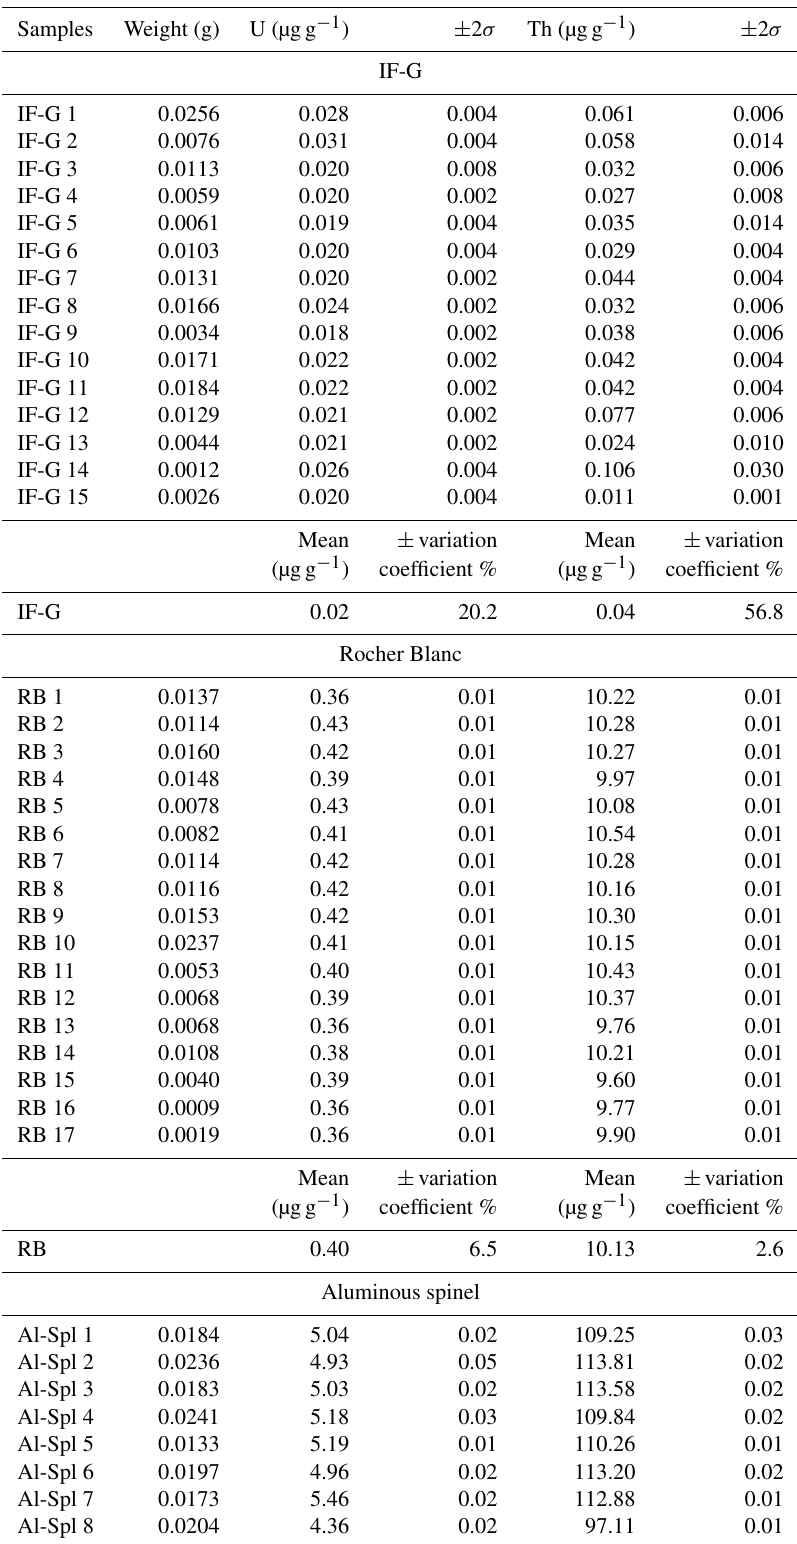
Table 4. U and Th concentration results obtained by dilution.